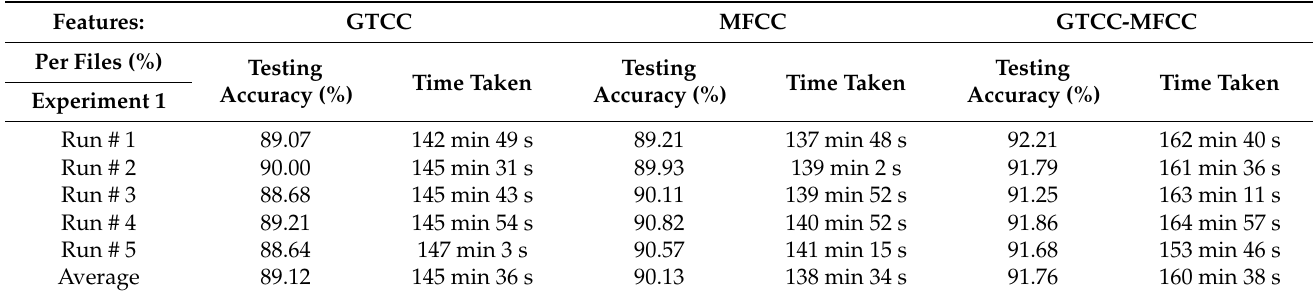
Table 5. Comparison of GTCC and MFCC for spoken LID in the proposed system.